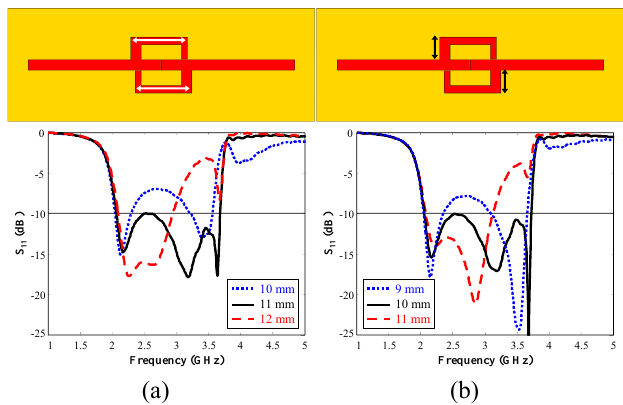
Figure 8: The effects of a) the dipole length b) the dipole width on the return loss performance.